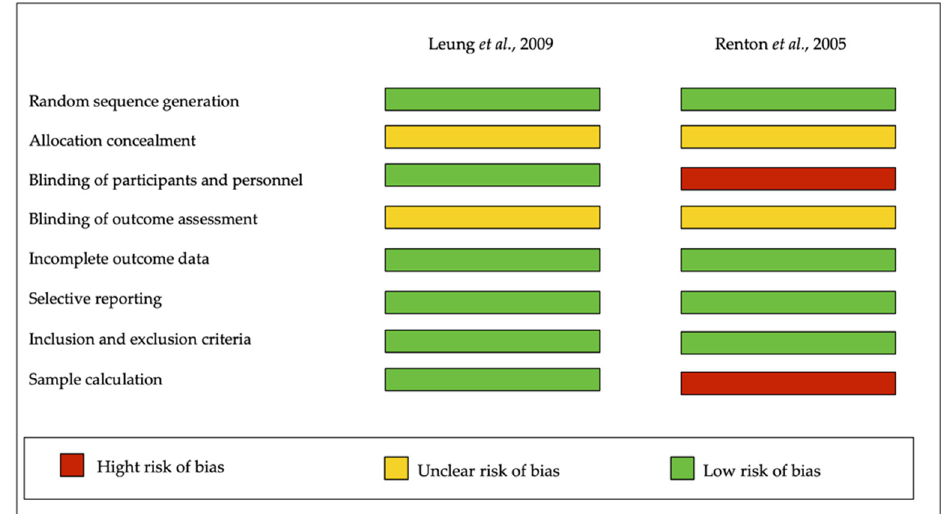
Figure 2. Cochrane Collaboration`s tool for assessing Risk of Bias.